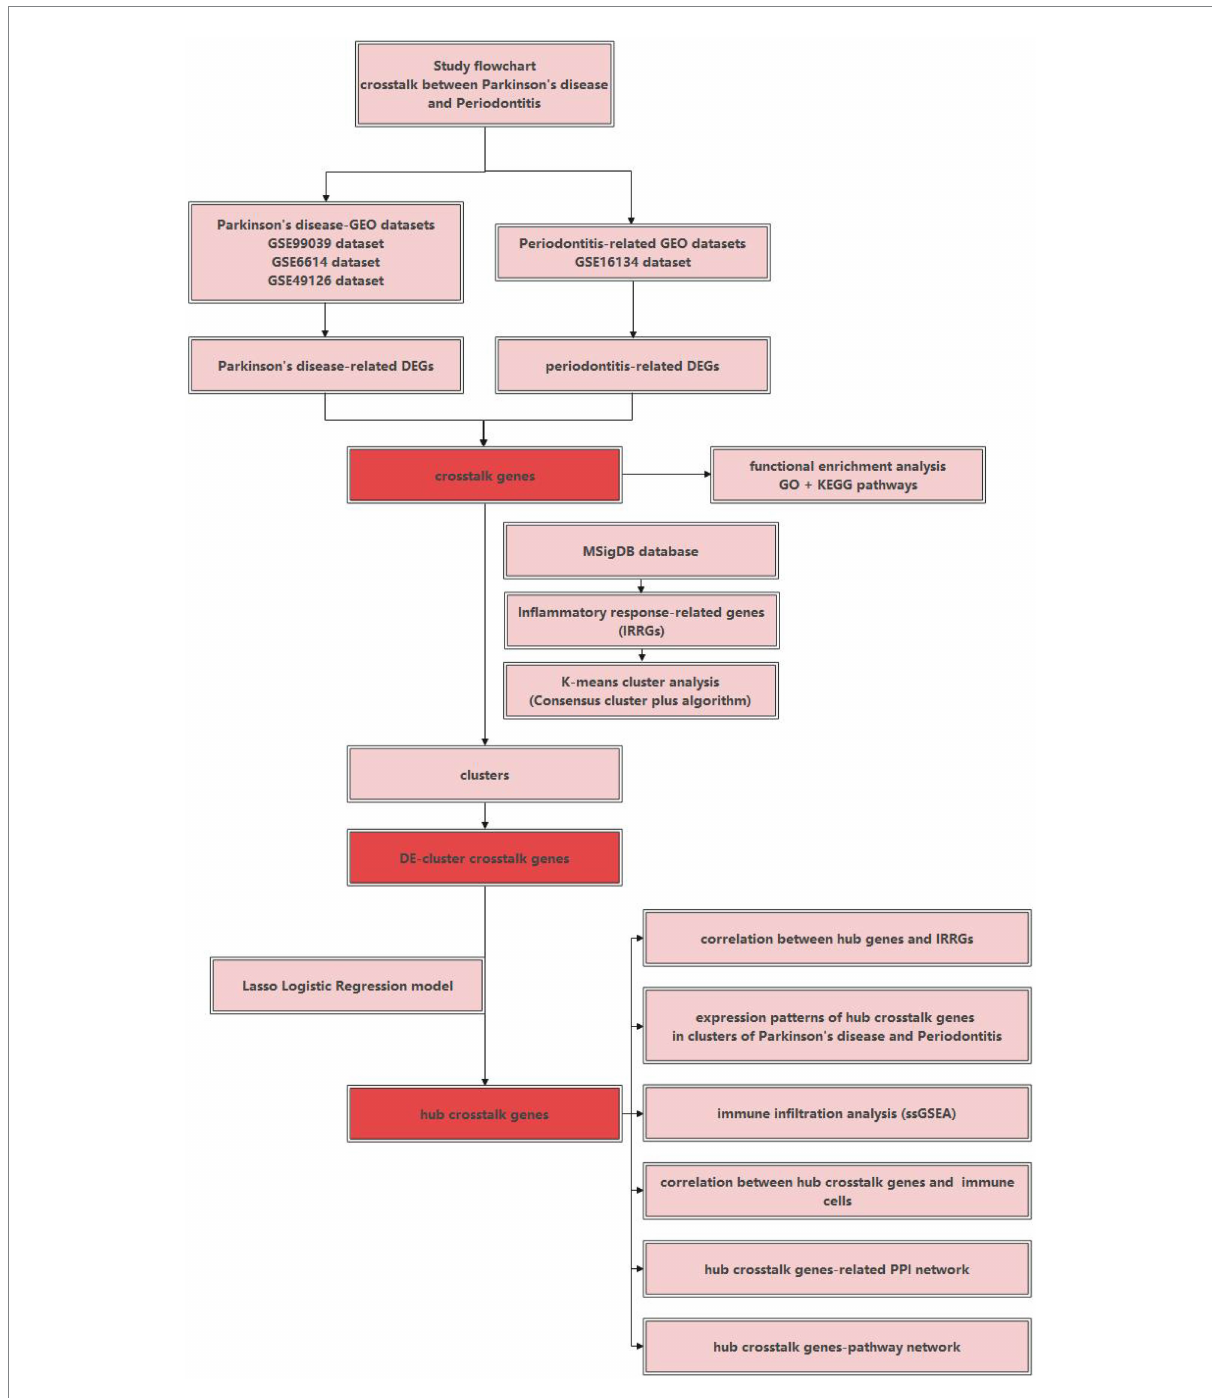
FIGURE 1 The study flowchart of the current